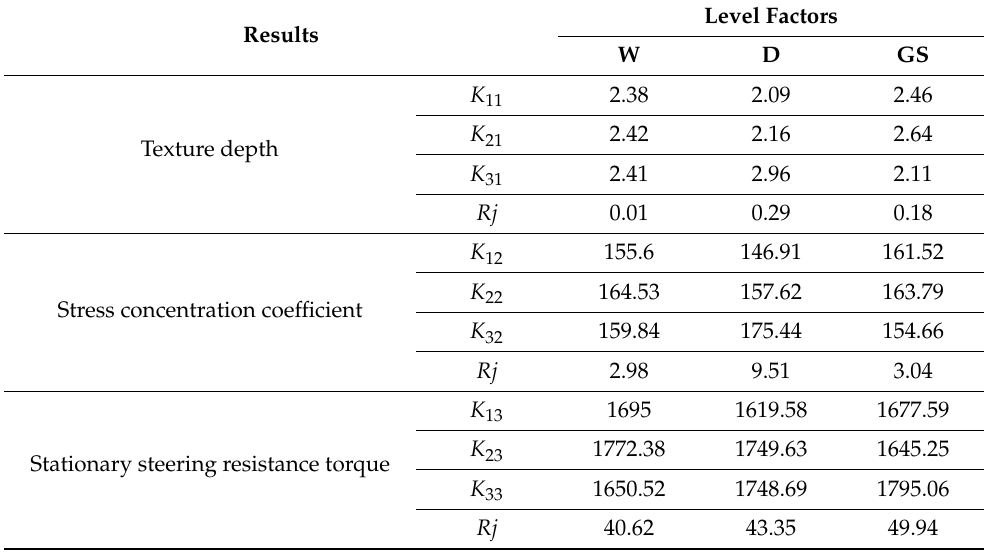
Table 6. Range analysis of the orthogonal test